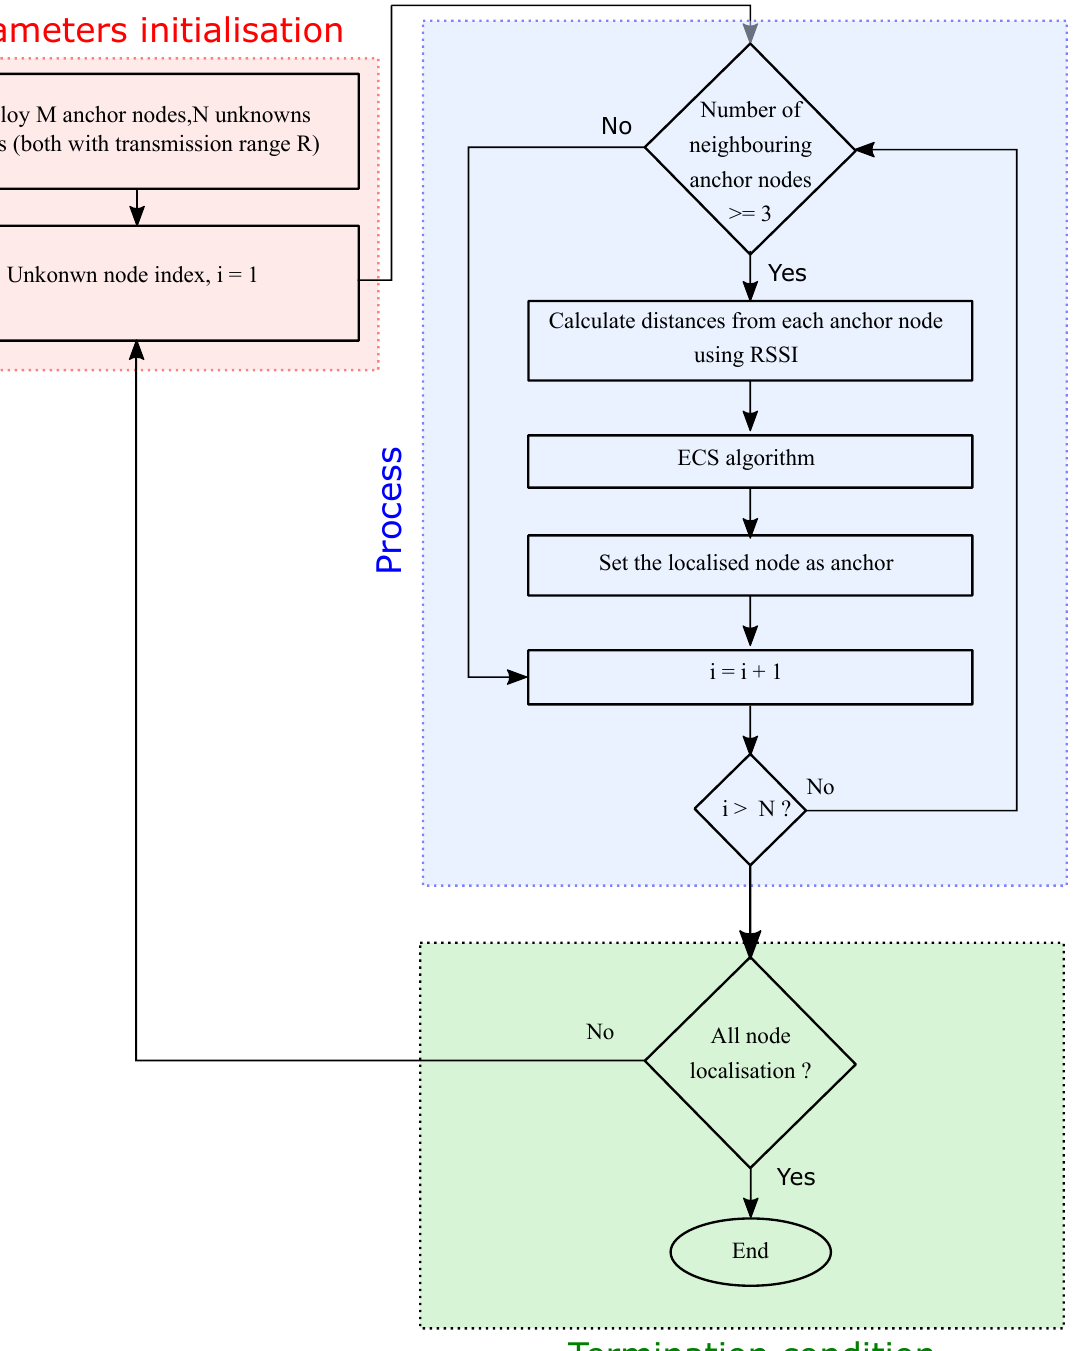
Figure 3. Node localisation process in